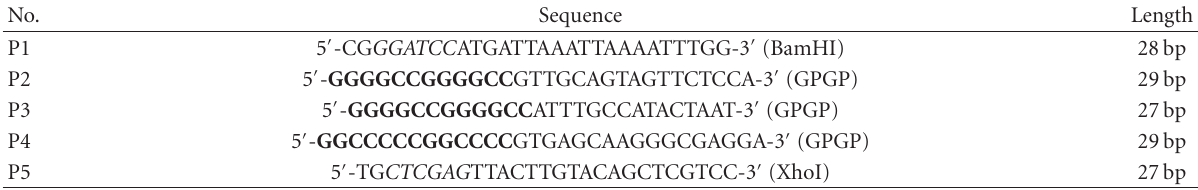
Table 1: Five primers synthesized for the construction of the fusion